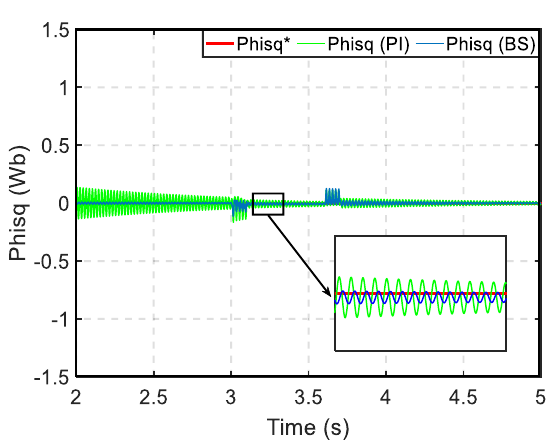
Fig. 20 Active irq current evolution